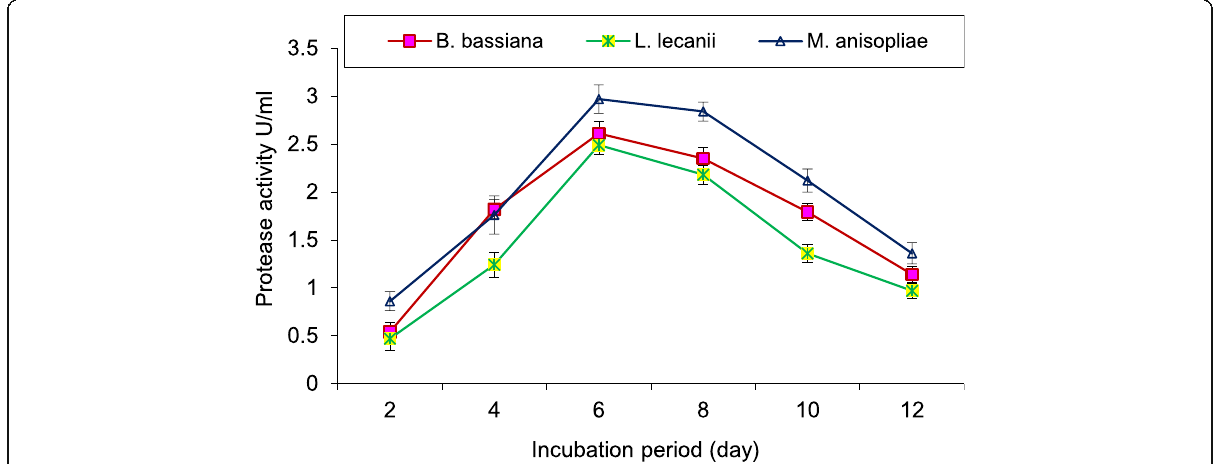
Fig. 3 Effect of incubation period on protease activity of the EPF isolates of Beauveria bassiana , Lecanicillium lecanii , and Metarhizium